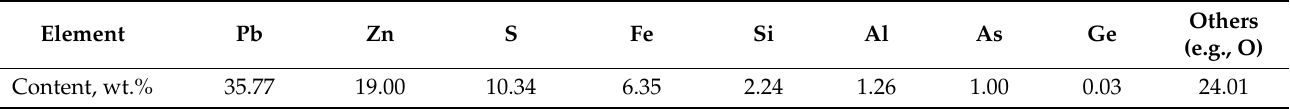
Table 4. XRF results of atmospheric leaching